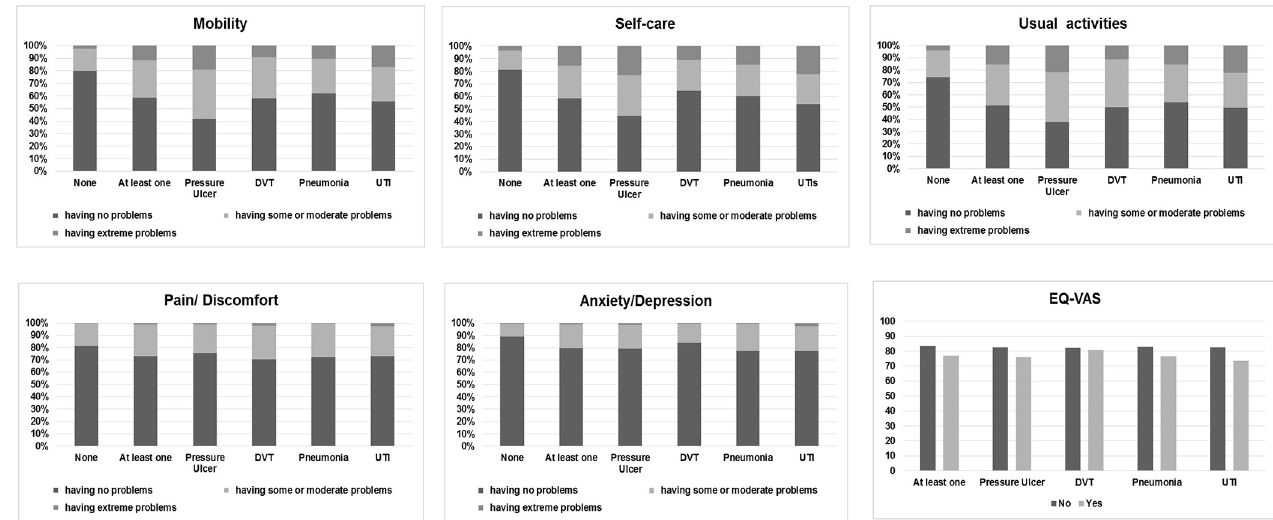
Fig 2. The distribution of the proportion of problems reported by patients with MCI in relation to five domains of the EQ-5D and EQ-VAS scores.